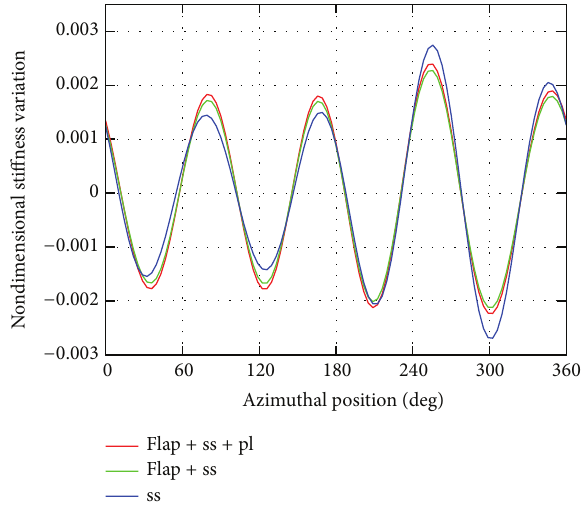
Figure 14: Lag smart spring bending stiffness time history.